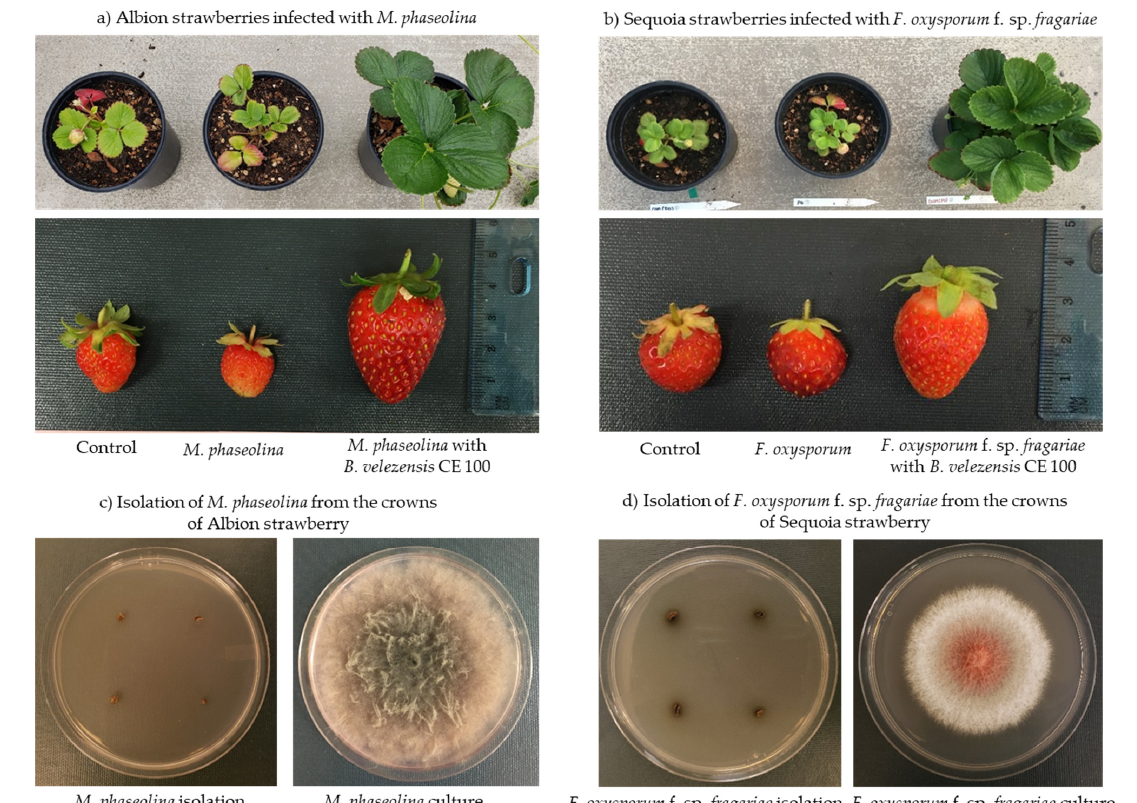
Figure 5. Effects of different treatments on growth and fruit production in Albion strawberries infected with Macrophomina phaseolina ( a ) and Sequoia strawberries inoculated with only Fusarium oxysporum f. sp . fragariae ( b ). Isolation of M. phaseolina ( c ) and F. oxysporum f. sp . fragariae ( d ) from infected crowns of the Albion and Sequoia strawberry plants, re- spectively.